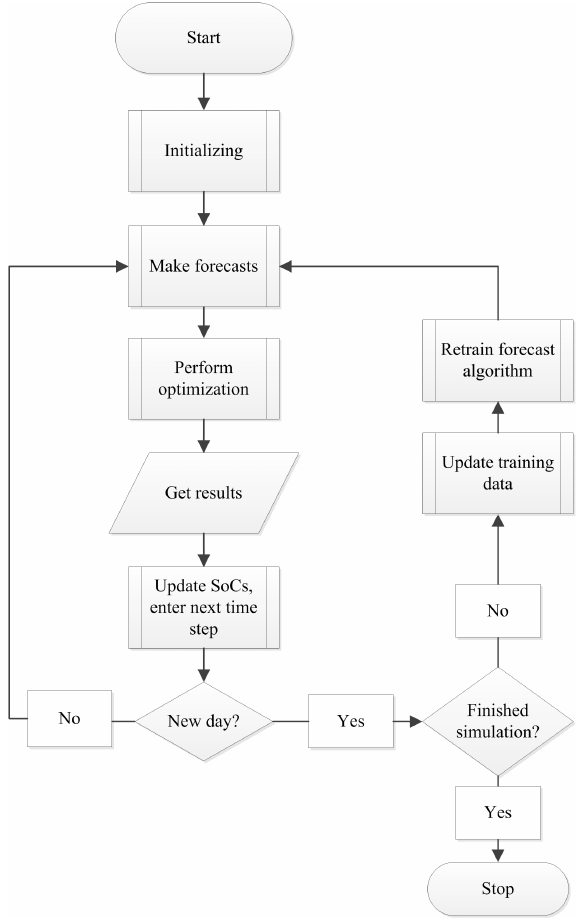
Figure 7. Simulation